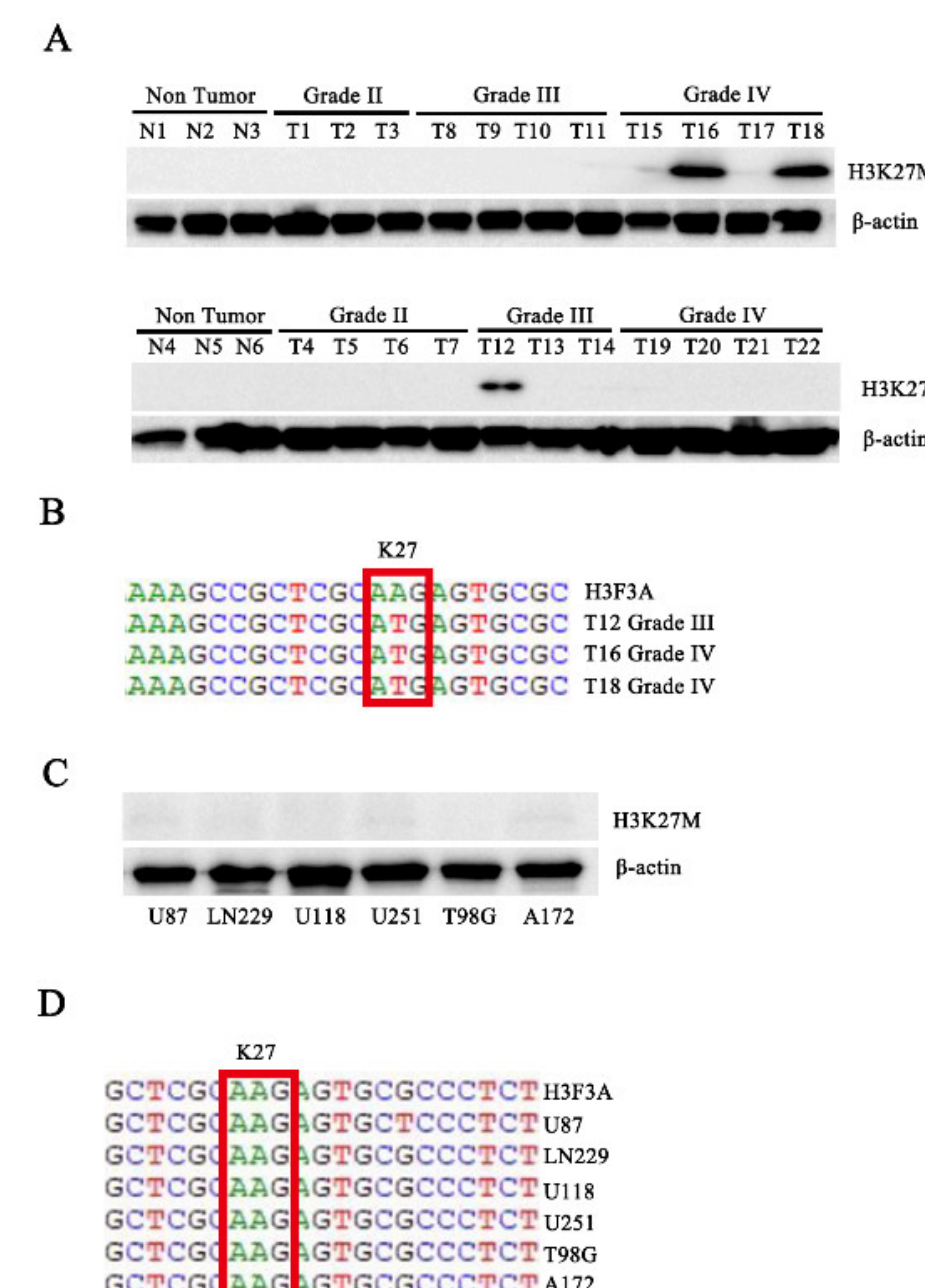
Figure 1. Western blotting and sequencing confirmed that the H3.3K27M mutation exists in human patients with glioma. ( A ) Western blot analysis of total proteins isolated from cancer tissue specimens of 28 to assess H3K27M protein levels. N indicates nontumor tissue, and T indicates tumor tissue. ( B ) Gene sequence showing the H3.3K27M mutation in three samples. ( C ) Six glioma cell lines were used to assess H3K27M protein levels using Western blotting. ( D ) Gene sequencing of the H3.3K27M mutation in six glioma cell lines.